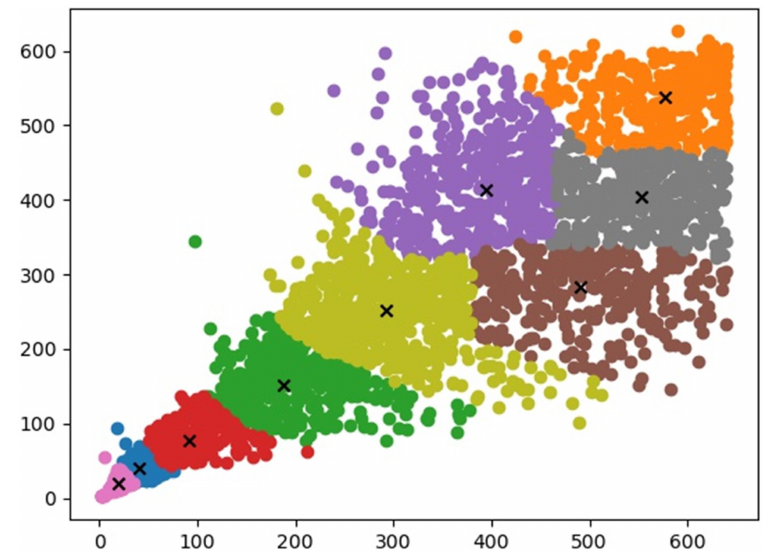
Figure 6. The visualization results of improved K-means++.